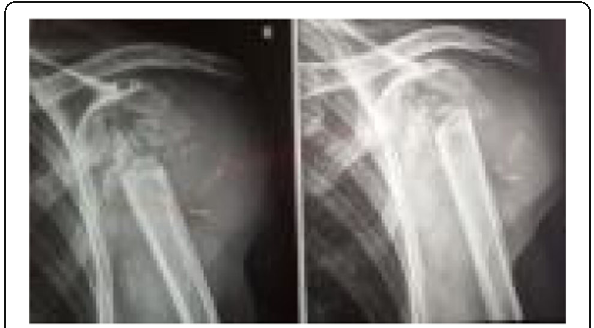
multiple intra-articular bone